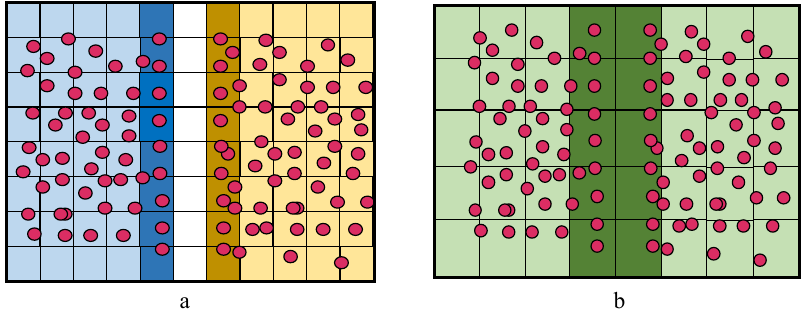
Figure 15. The segmentation result by using different voxel sizes to process the red point cloud. ( a ) segmentation result of small voxel size, two planes have been segmented and ( b ) segmentation result of bigger voxel size, only one plane has been segmented.